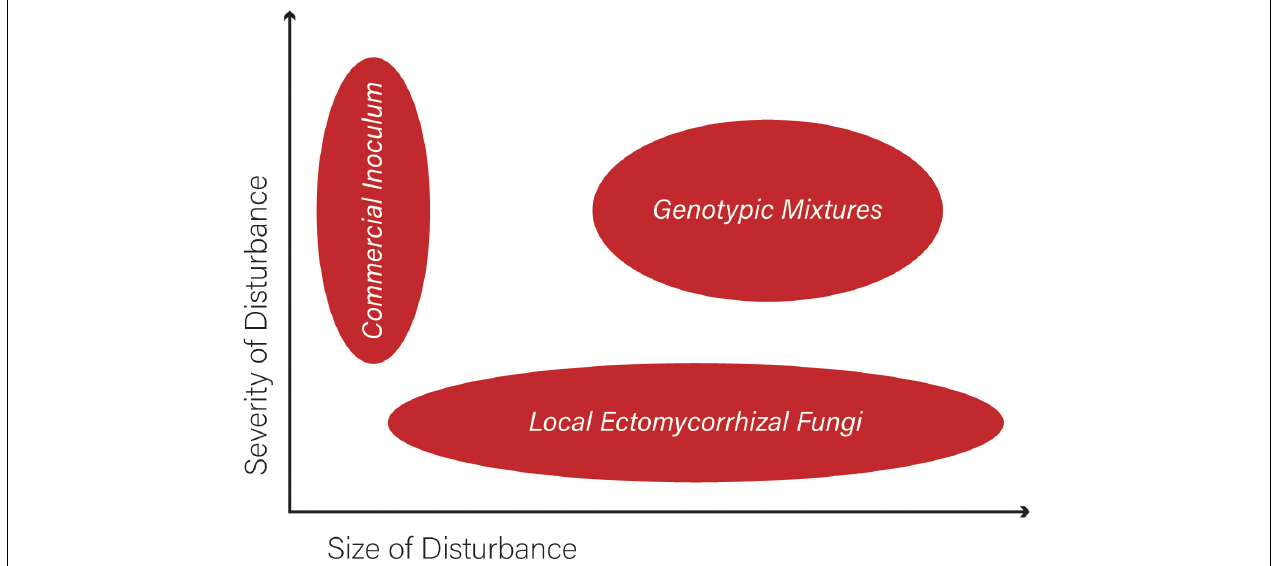
FIGURE 2 | The severity and size of a disturbance will impact the use of ectomycorrhizal fungi in a plant restoration effort. The best choice for all sizes of disturbances is to use locally adapted EMF species. As one moves to more severe disturbances, it may be necessary to use commercial inoculum that is more generally adapted because the site has been too degraded for locally adapted genotypes. As the size and severity of the disturbance increases it is necessary to use multiple EMF species and as much genetic variation as possible within species (e.g., collecting fungi from many local microhabitats) to increase the chances of restoration success. Adapted from Lesica and Allendorf